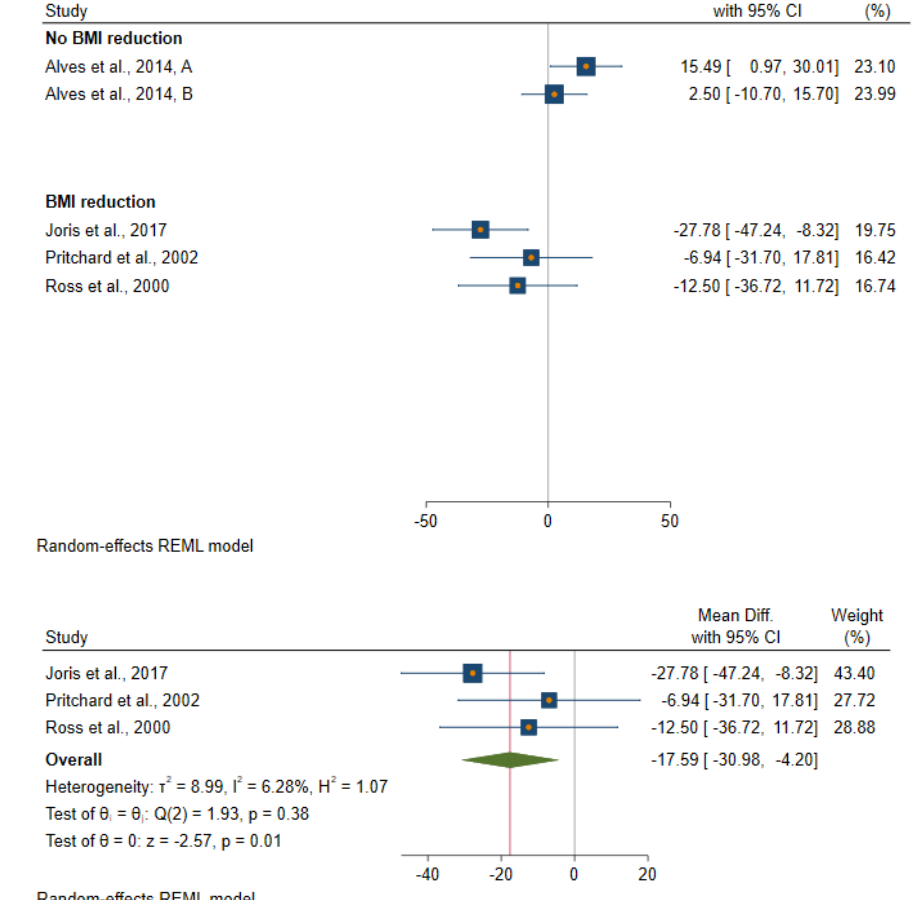
Figure 4. Forest plot of studies which evaluated an effect of a reduction in body fatness on fasting insulin levels.